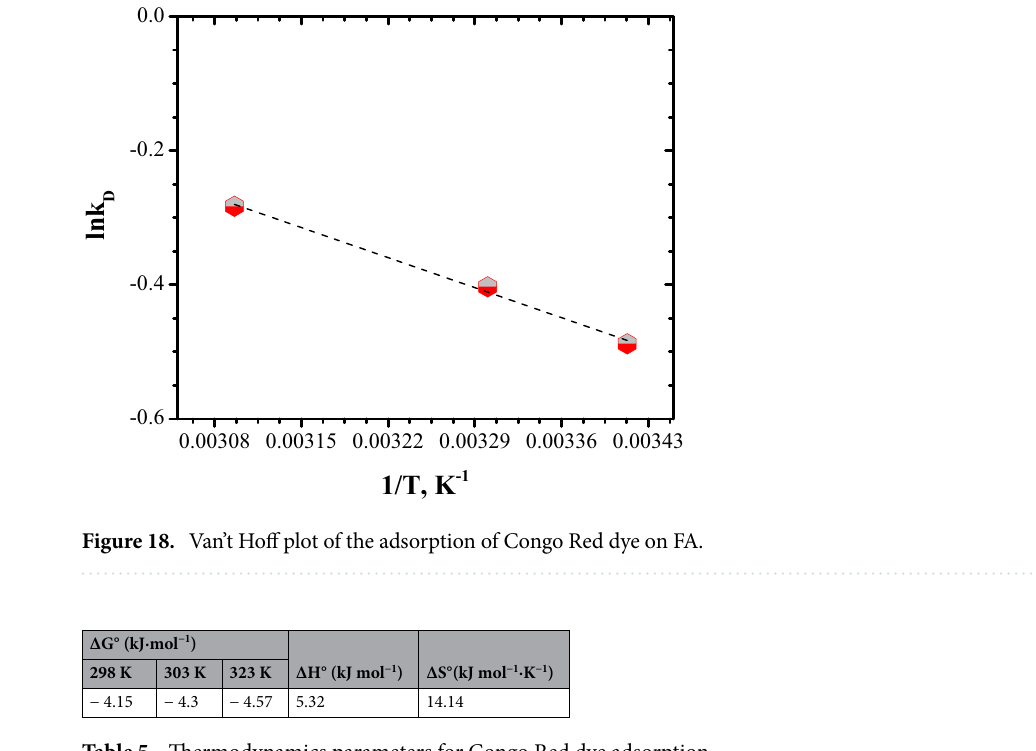
Table 5. Thermodynamics parameters for Congo Red dye